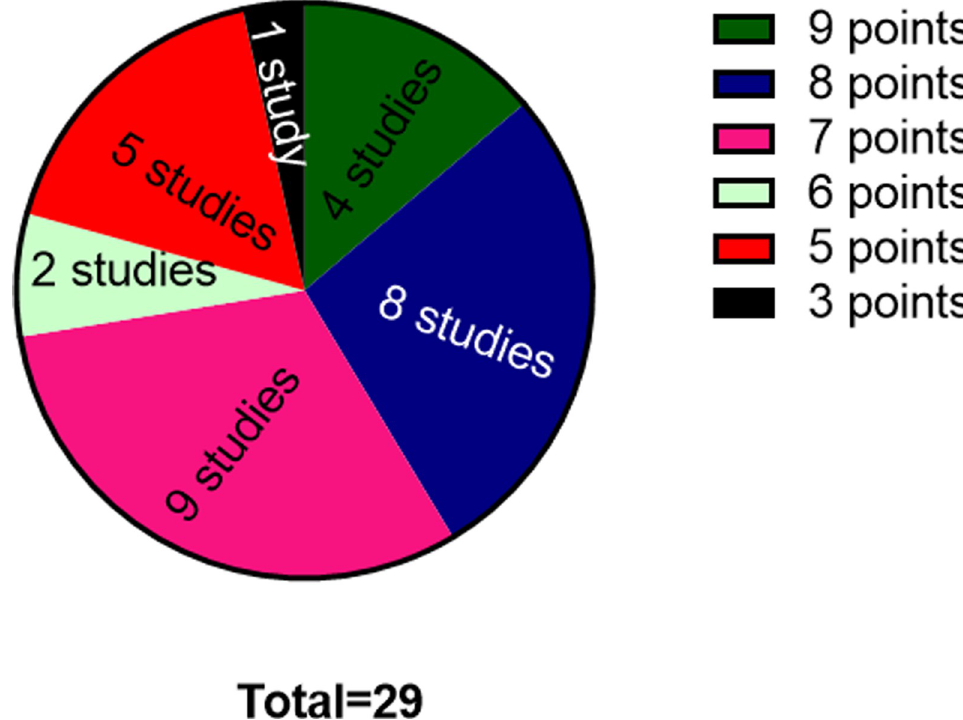
Fig 2. Analysis of study quality considering the quality assessment of studies included in systematic review as per the Systematic Review Centre for Laboratory Animal Experimentation’s (SYRCLE).